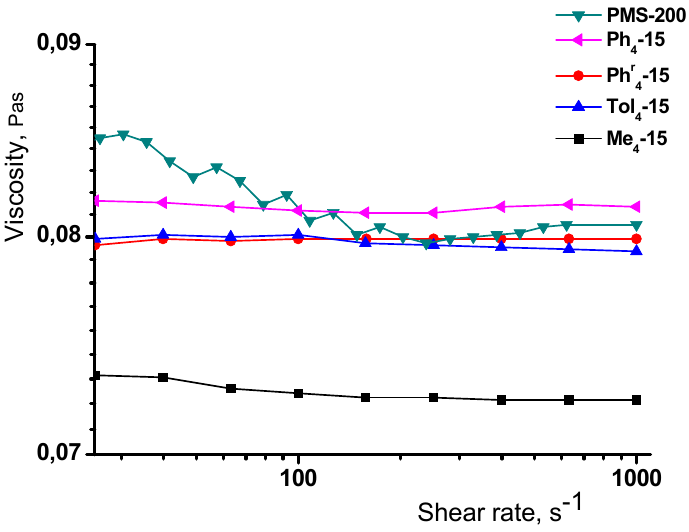
Figure 7. Ph r4 -15, Me 4 -15, Tol 4 -15, Ph 4 -15 , and PMS-200 flow curves at 20 ° C. For linear polymer, the Newtonian flow begins at shear rates over 100 s − 1 . At smaller shift rates, viscosity decreases as the shift rate grows that is related to gradual orientation of polymer macromolecules in the shear field. SSP viscosity in the whole interval of shear rates is less than for linear polymer, and Me 4 -15 has the least viscosity among SSPs . Flow curves of Ph 4 -15 at various temperatures are presented in Figure 8. Similar de- pendencies were also obtained for other SSPs .